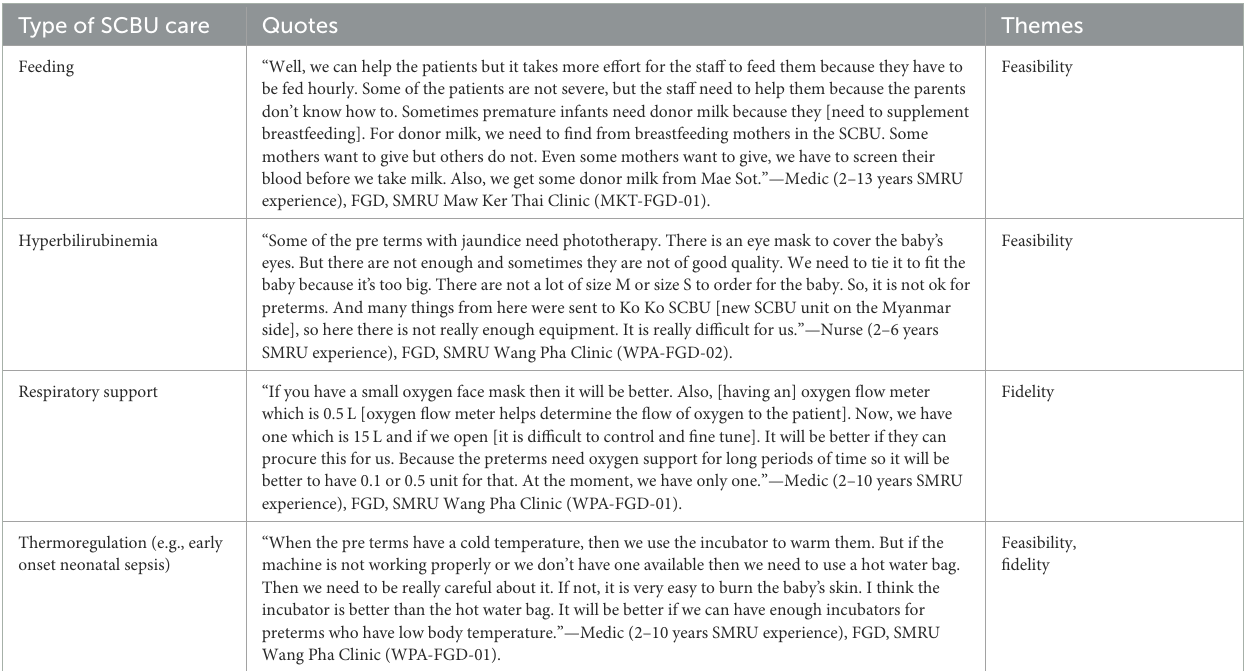
TABLE 4 Exemplary quotes from focus group discussions with medical staff highlighting resource-poor setting effects on feasibility and fidelity of evidence-based SCBU